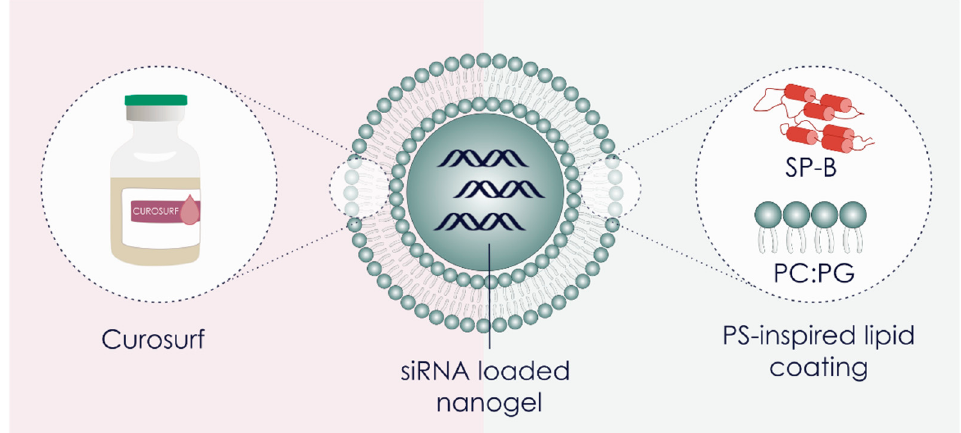
Figure 1. Visual representation of the core-shell surfactant-coated nanogel structure. SiRNA-loaded dextran nanogels (siNGs) were coated with Curosurf ® (poractant α ; porcine derived clinical pulmonary surfactant (PS)) or with a PS-inspired lipid coating containing the surfactant protein B (SP-B) and an anionic lipid mixture. PC = phosphatidylcholine, PG = phosphatidylglycerol.